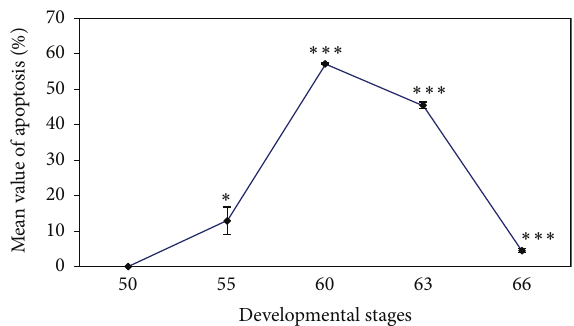
Figure 9: Graph showing the correlation between the percentage of DNA damage and the investigated developmental stages within the small intestine using cell cycle analysis. Data are represented as mean ± SEM ( 𝑛 = 6 ). ∗∗∗ 𝑃 < 0.0001 , ∗ 𝑃 < 0.05